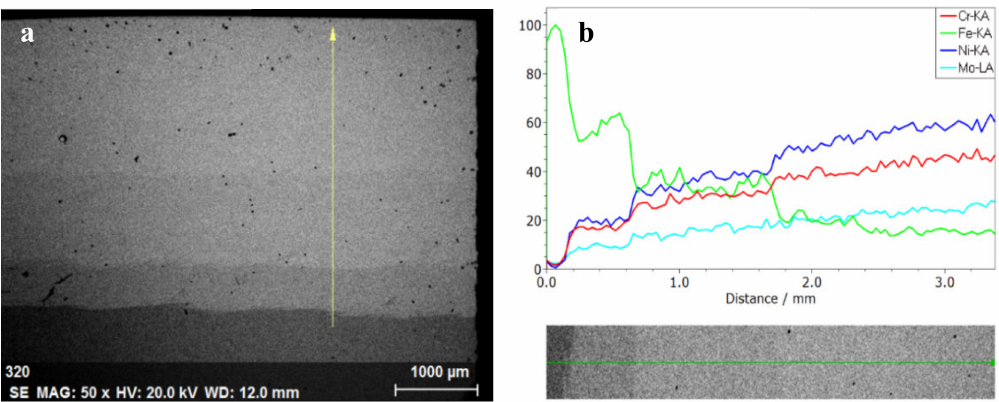
Figure 3. ( a ) SEM micrograph and ( b ) element di ff usion curve of an overall cross-section of the C22 coating.